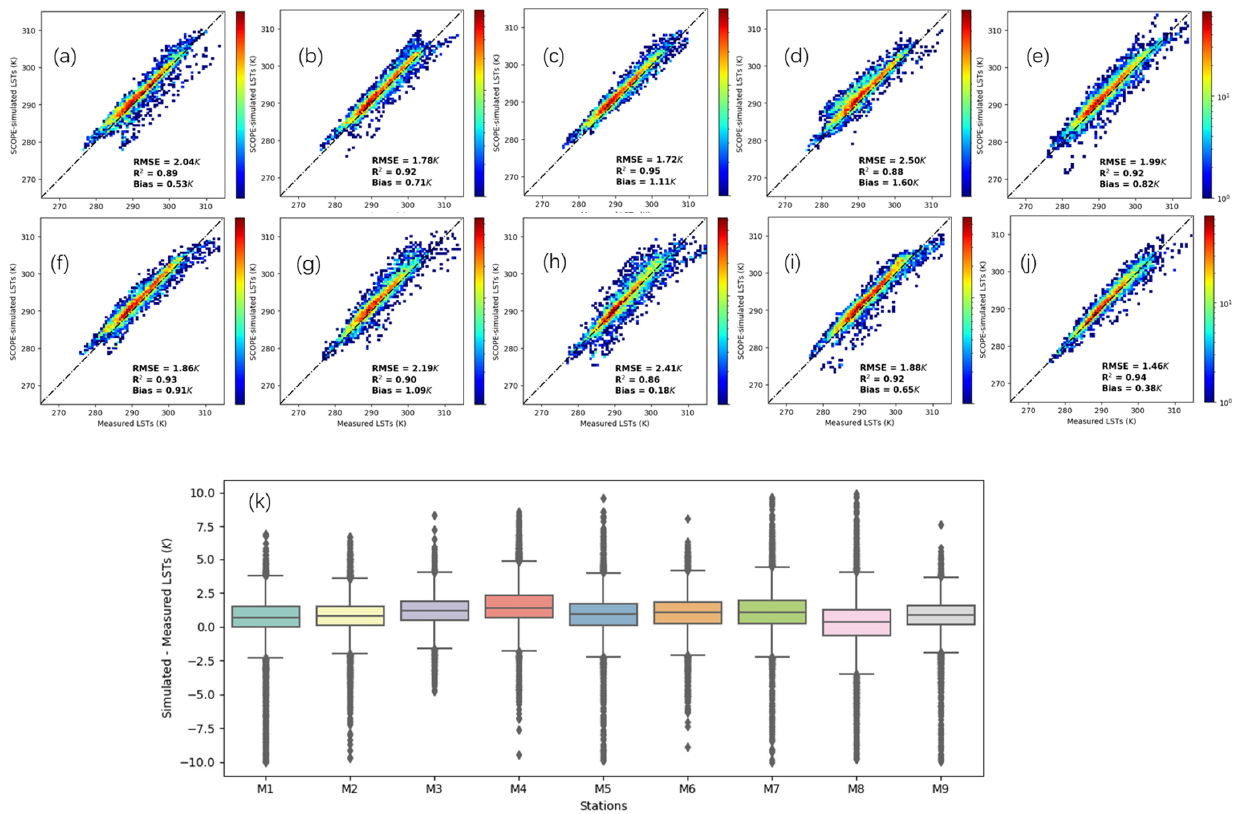
Figure 4. Scattering plots between measured and SCOPE-simulated brightness temperatures. ( a – j ) correspond to cases M1–M10 in Table 1. ( k ) The boxplot of differences between SCOPE-simulated and measured brightness temperatures.